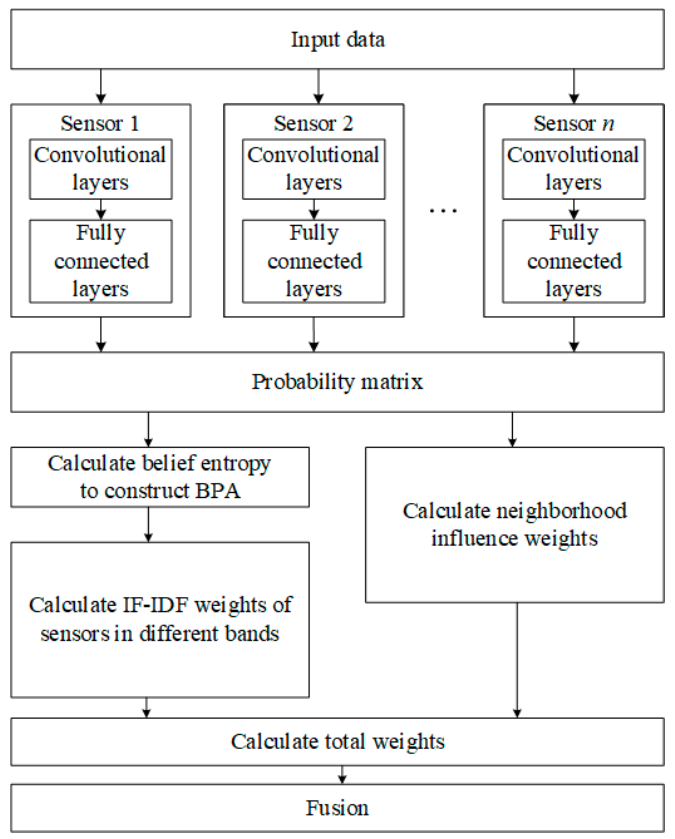
Figure 2. The flowchart of an SAR image classification method based on the decision-level combination of multi-band information.